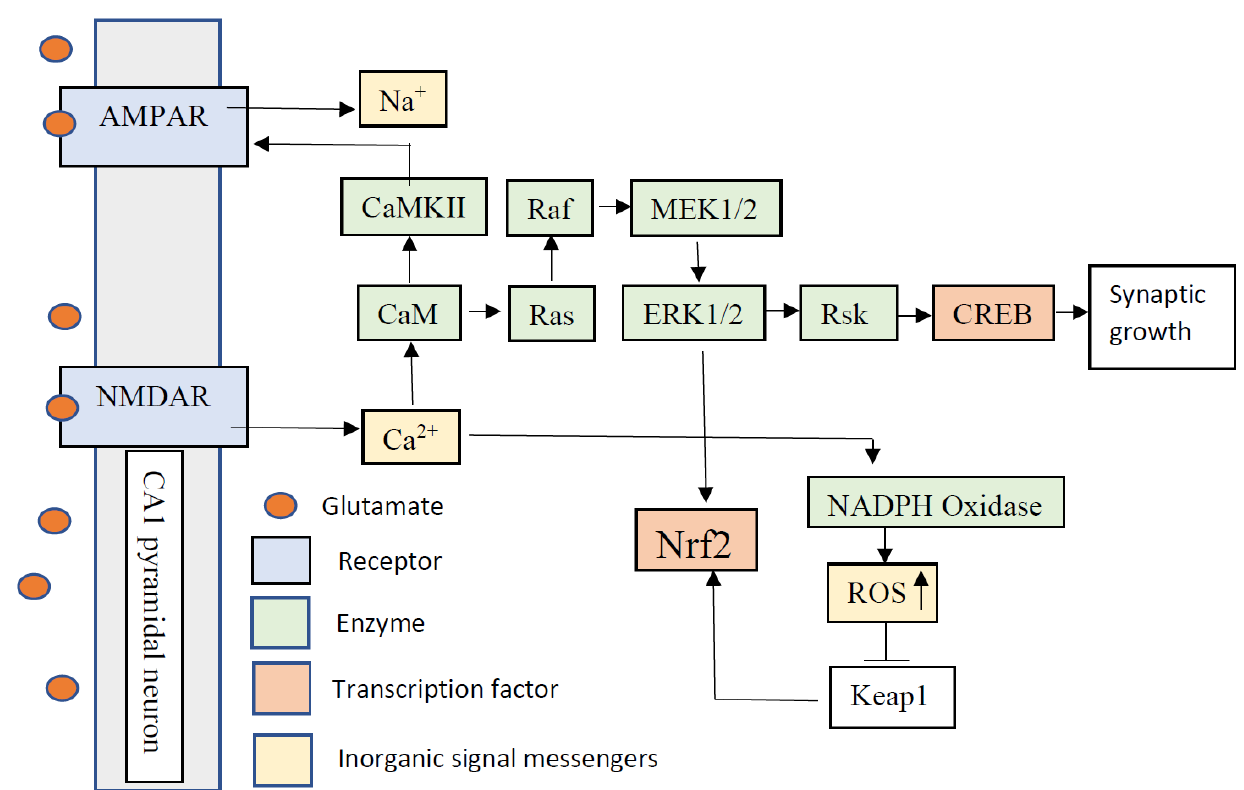
Figure 2. Putative Nrf2 signaling pathway during long-term potentiation (LTP) in the CA1 region of the hippocampus. Membrane depolarization and glutamate binding to the postsynaptic membrane receptors induce N-methyl-D-aspartate receptor (NMDAR) activation, and result in Ca 2+ entry into the postsynaptic membrane. Ca 2+ activates calmodulin (CaM) and calcium-calmodulin-dependent protein kinase II (CaMKII) and results in α -amino-3-hydroxy-5-methyl-4-isoxazolepropionic acid receptor (AMPAR) phosphorylation. When glutamate binds to AMPAR, they become permeable to Na+, which is important for stable activation of NMDAR. Ca 2+ activates MAP kinase pathways (Ras/Raf/MEK1/2-ERK1/2-Rsk), which phosphorylate cAMP response element-binding protein (CREB). CREB induces mRNA transcription for synapse growth. Extracellular signal-regulated kinases (ERK1/2) can phosphorylate nuclear factor erythroid 2 – related factor 2 (Nrf2). Keap1 is a negative regulator of Nrf2. Reactive oxygen species (ROS) inactivate Keap1, which allows Nrf2 to become active. NADPH oxidase is an ROS source that can be activated by Ca 2+ , and is translocated into neurons via NMDA receptors.